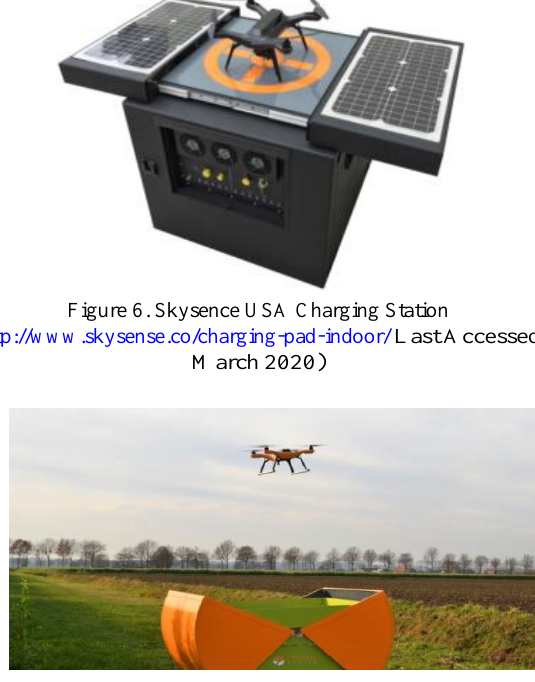
Figure 7. CorvusDrones charging station